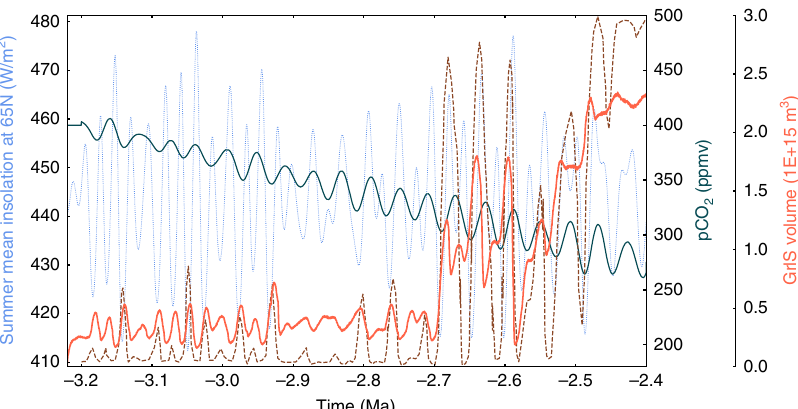
Fig. 4 Simulated GrIS volume evolution with the pre-de fi ned best scenario of pCO 2 from Willeit et al. 28 . The brown dash line represents the GrIS evolution of Willeit et al. 28 under the same pCO 2 scenario. The dashed light blue line represents the boreal summer insolation